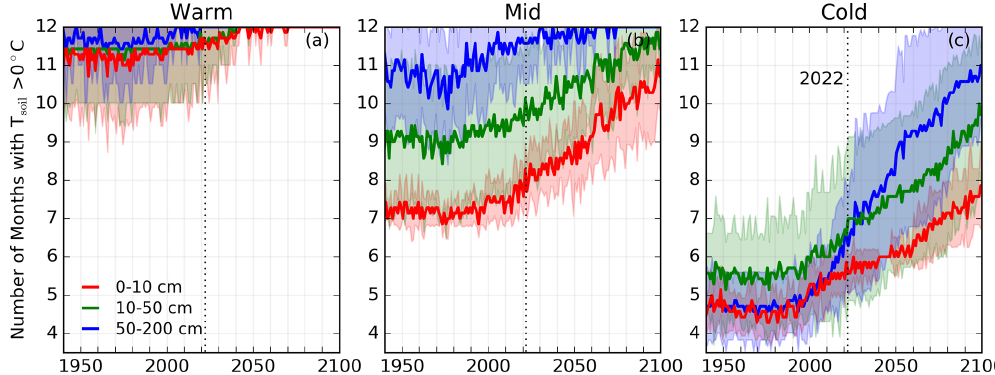
Figure 6. Number of months per year with monthly mean soil temperatures above 0 ◦ C at depths of 0–10cm (red), 10–50cm (green), and 50–200cm (blue) simulated by seven CMIP6 models under ssp585 for the (a) Warm, (b) Mid, and (c) Cold regions. The solid lines show the model mean, and shading shows ±